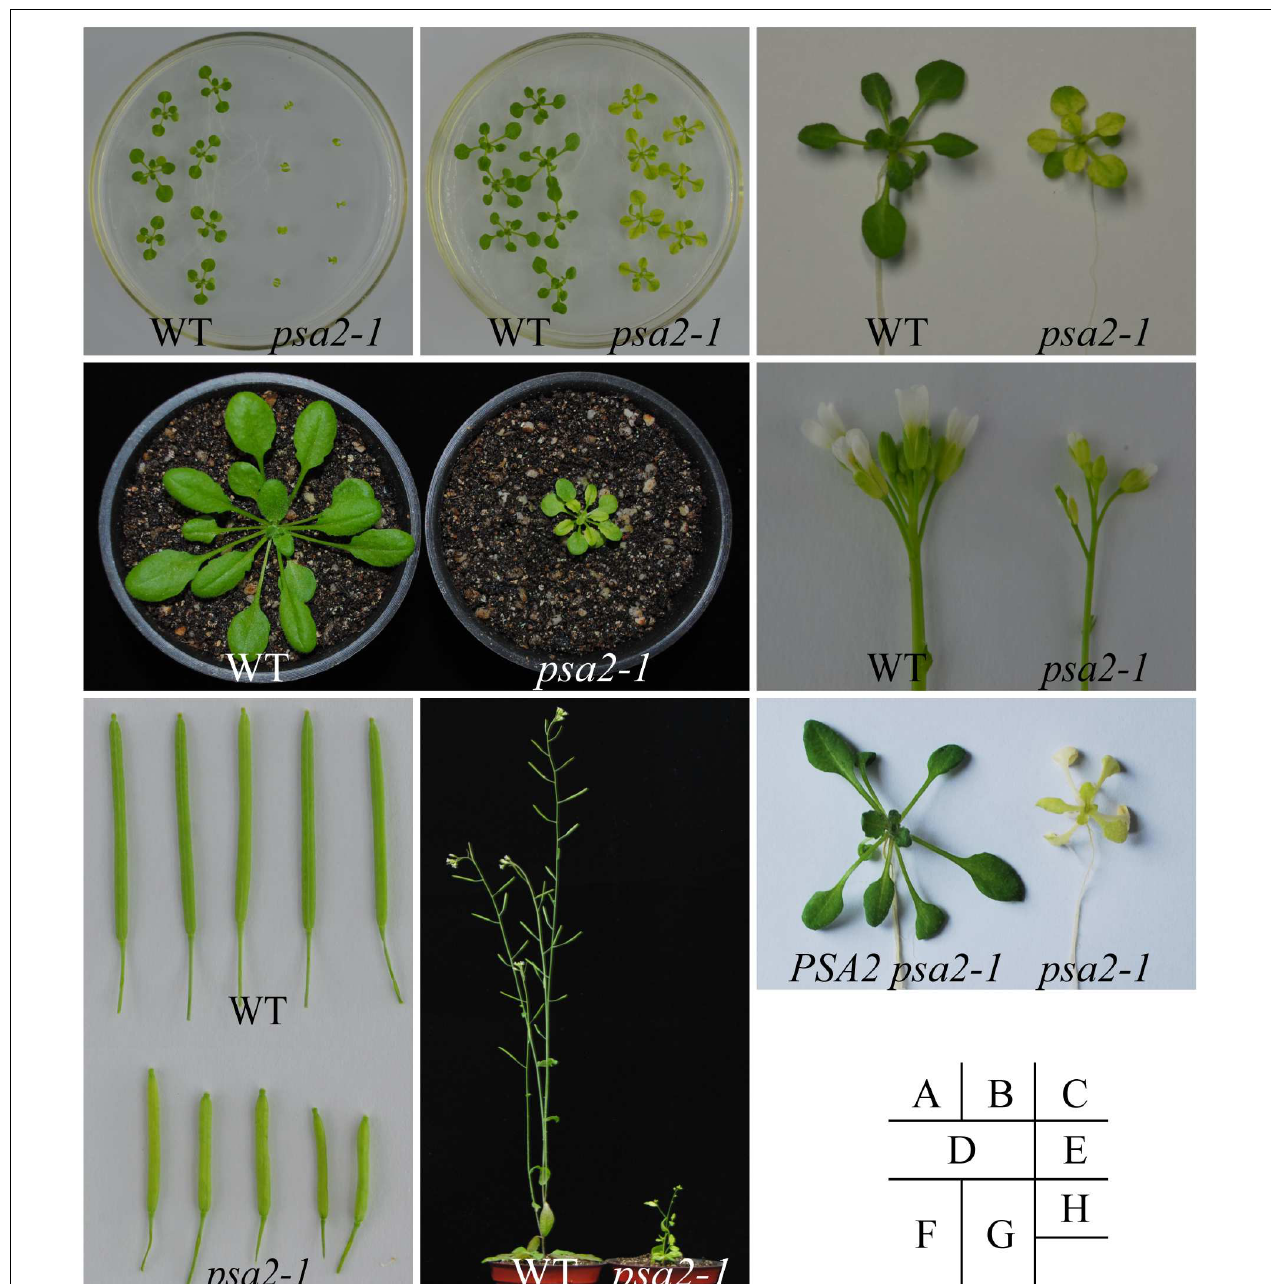
FIGURE 2 | Phenotype of the psa2-1 mutant plants. (A,B) psa2-1 seedlings germinated on MS plates without (A) or with (B) 1% sucrose for 2 weeks. (C) psa2-1 seedlings grown in soil for an additional 2 weeks after germination on MS plates. (D) A representative psa2-1 seedling grown in soil for 4 weeks after germination on MS plates. (E–G) Inflorescence (E), siliques (F) , and mature plant (G) of the psa2-1 mutant. (H) Transformation with a wild type PSA2 gene fragment complemented the growth of psa2-1 . Seedlings germinated on MS plates for 2 weeks were photographed.